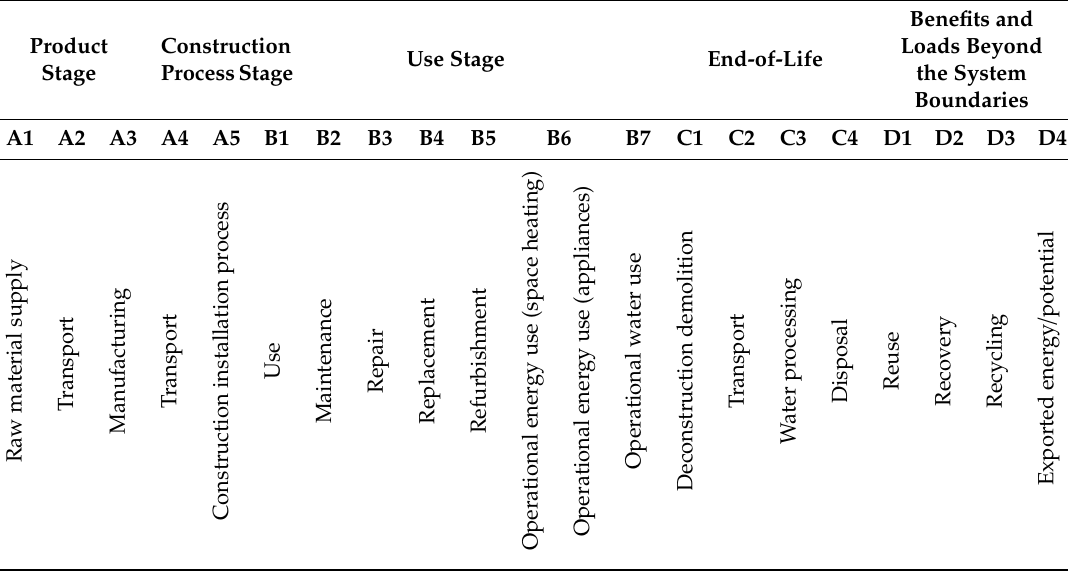
Table 3. Building life cycle phases according to [55].